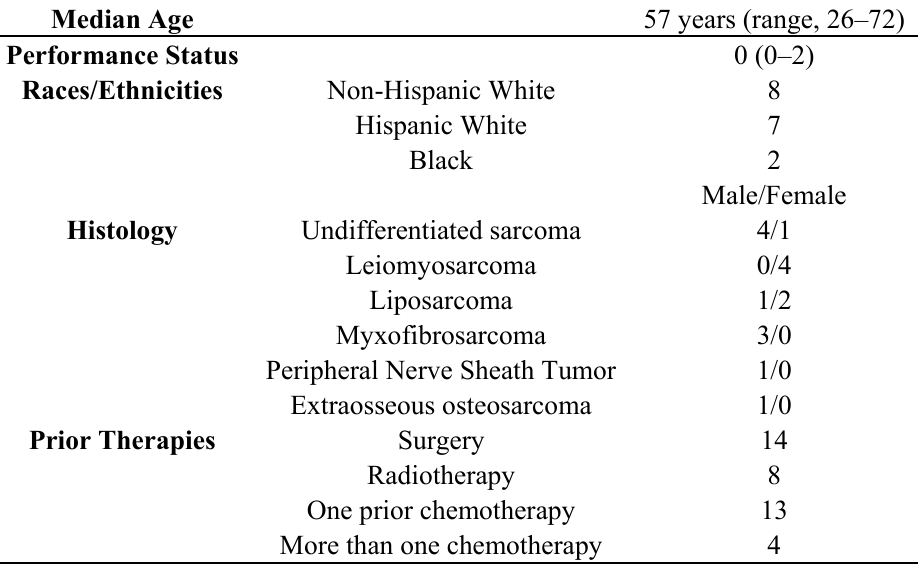
Table 1. Patient characteristics (N =